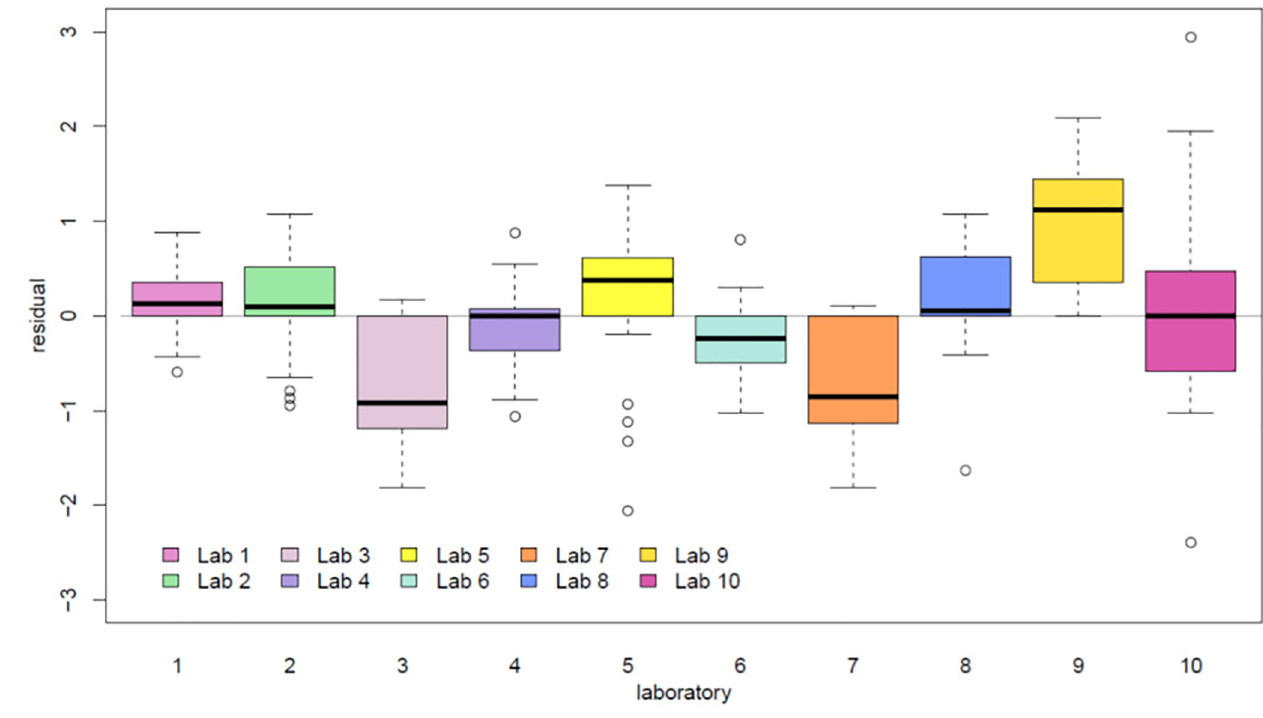
Fig 5. Distribution of Ct value residuals plotted by laboratory. C t value residuals were calculated as the C t values minus the sample-specific average C t value.